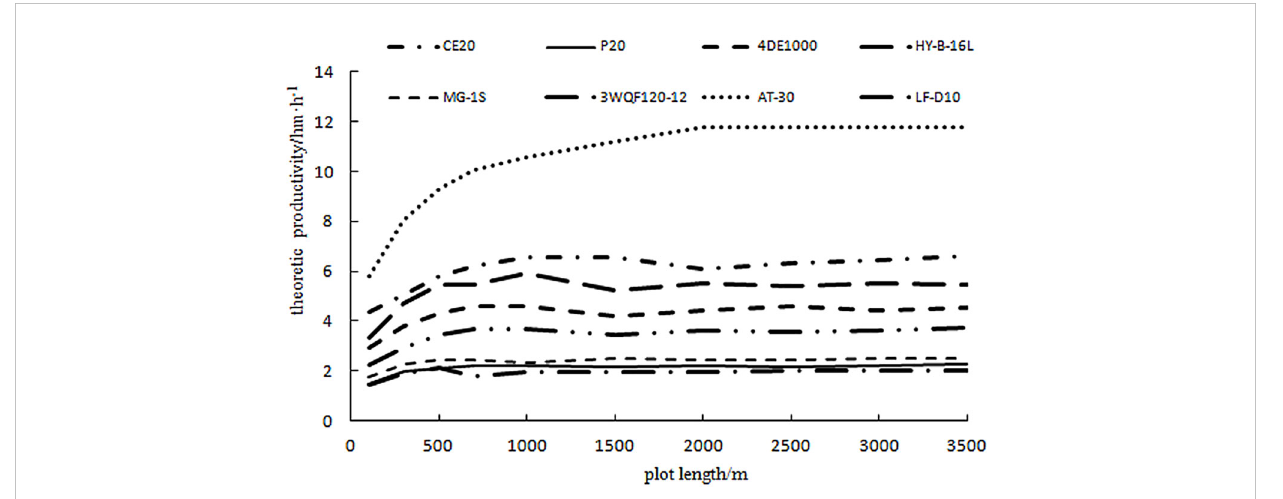
FIGURE 2 Curves of theoretical productivities at different plot